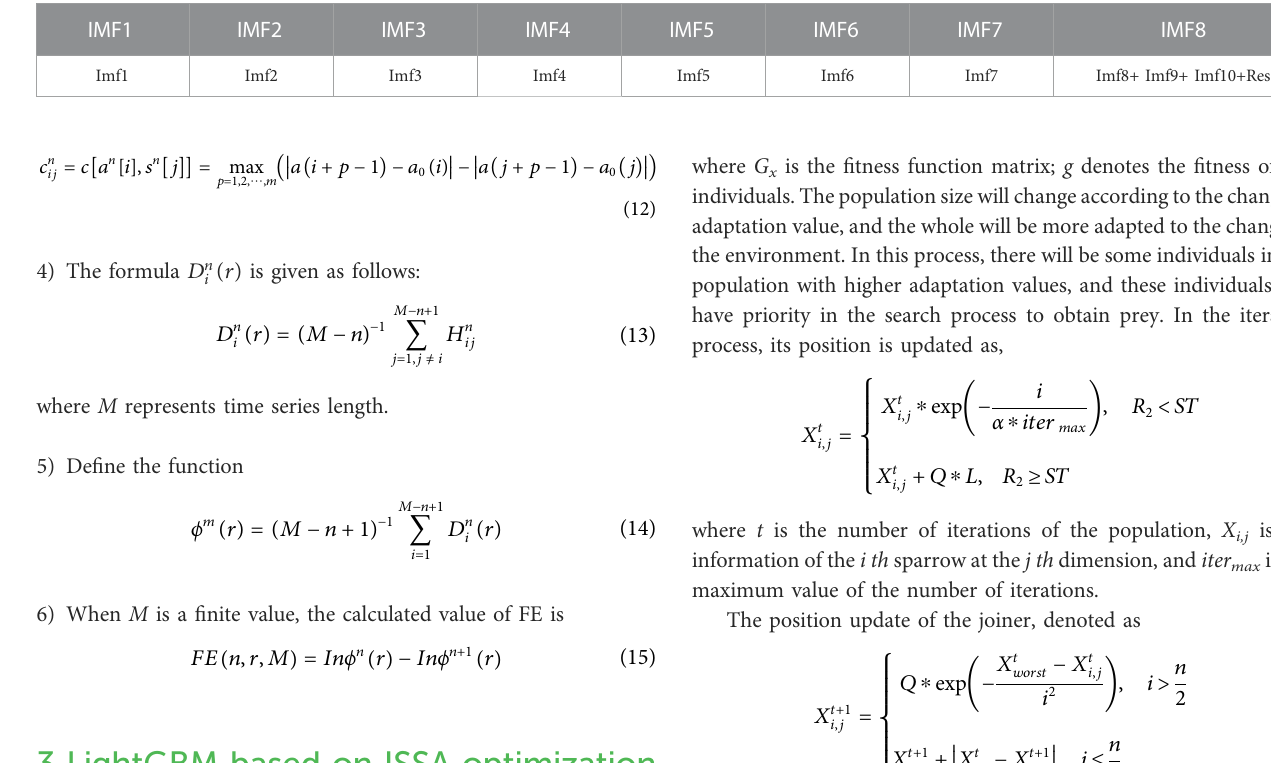
TABLE 3 Recombination of each